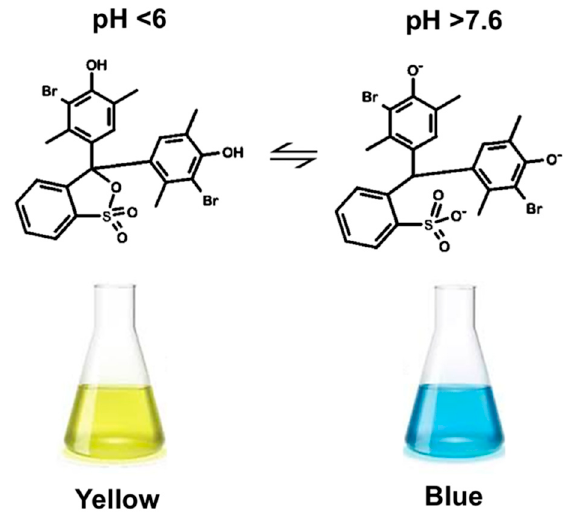
Figure 3. Change in chemical structure and color of bromoxylenol blue (BB) as a function of pH. The color shifts from yellow (at pH < 6) to blue (at pH >7.6).